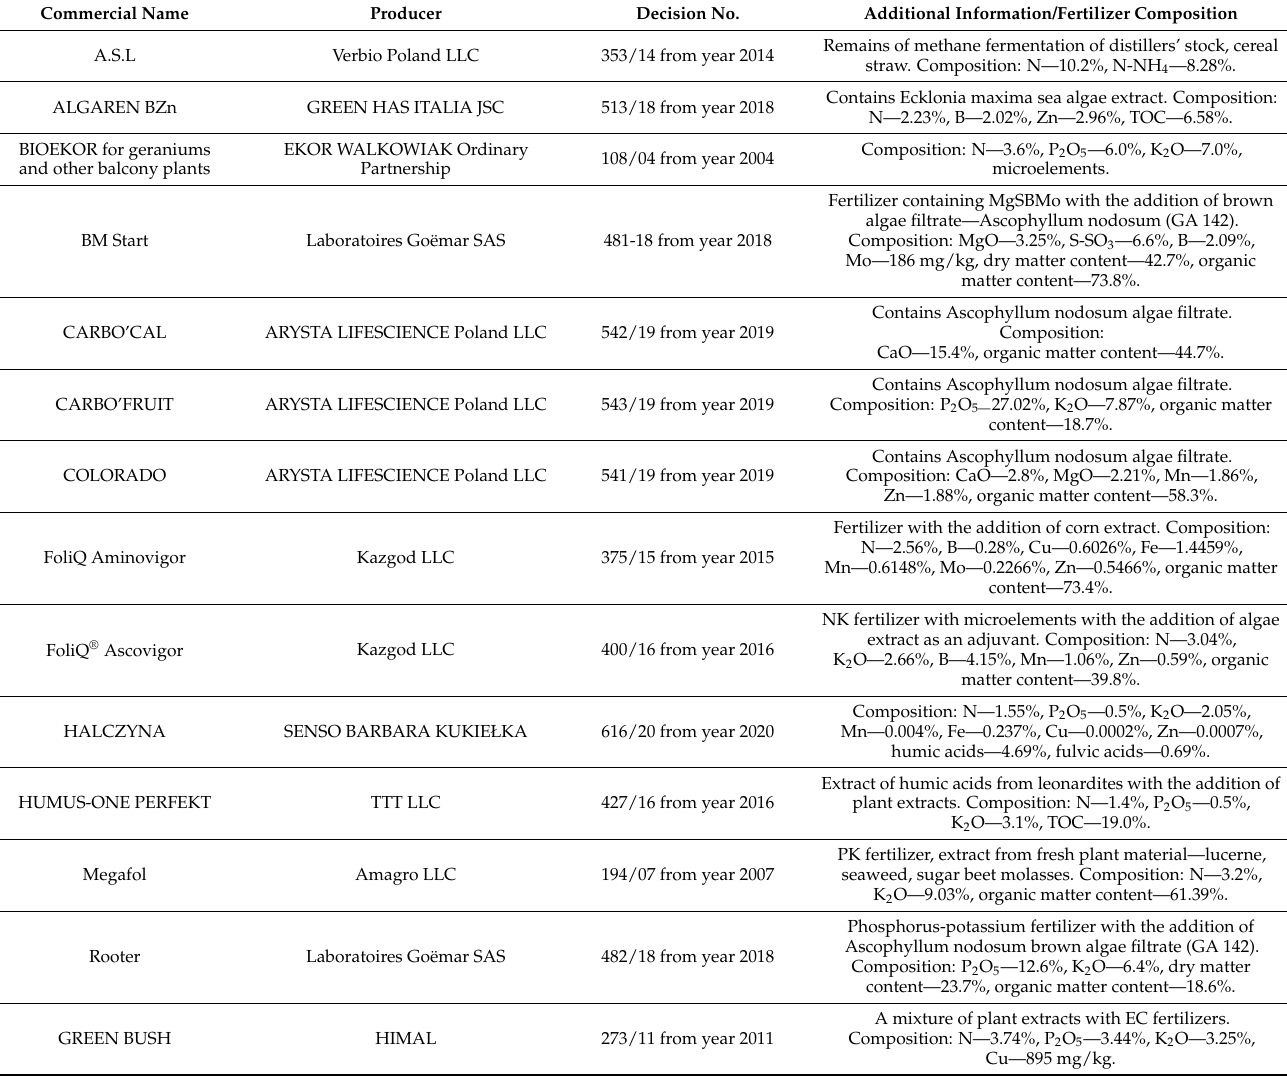
Table 9. Selected organic–mineral fertilizers in liquid form (authors’ own elaboration based on